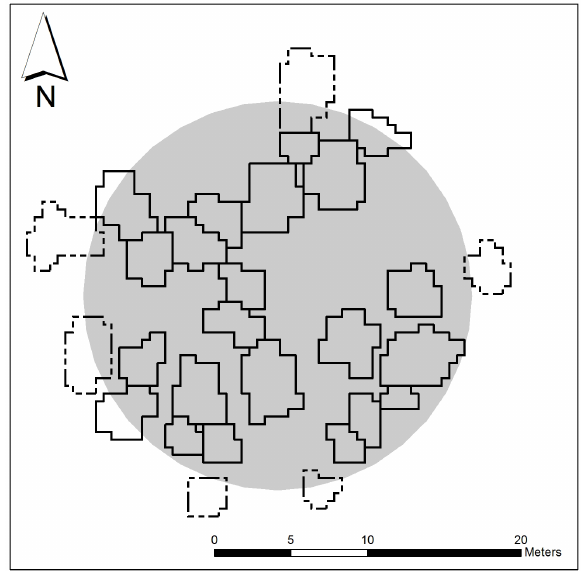
Figure 3. Results of two sample rules based on centroid (polygons (trees segments) with solid line) and ‘touch’ (polygons (trees segments) with dashed line and with solid line) based on sample plot area (gray circle with 12.62 m